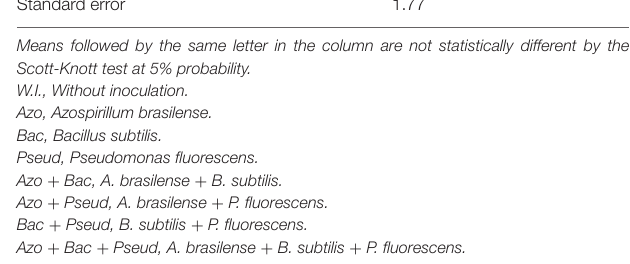
inoculation may solubilize the soil attached P because P applied from fertilizer wasn’t available for the plant